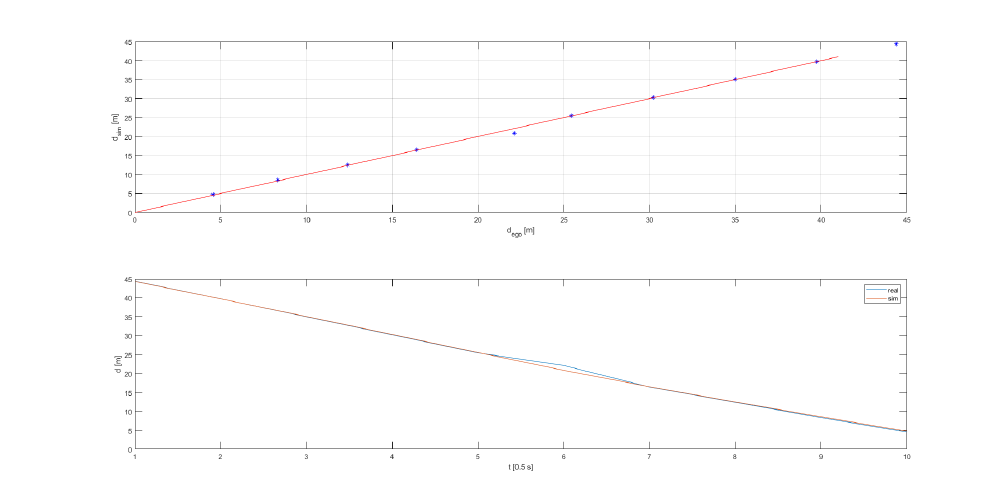
Figure A9. Validation of the real and estimated distance between ego target vehicle in scenario